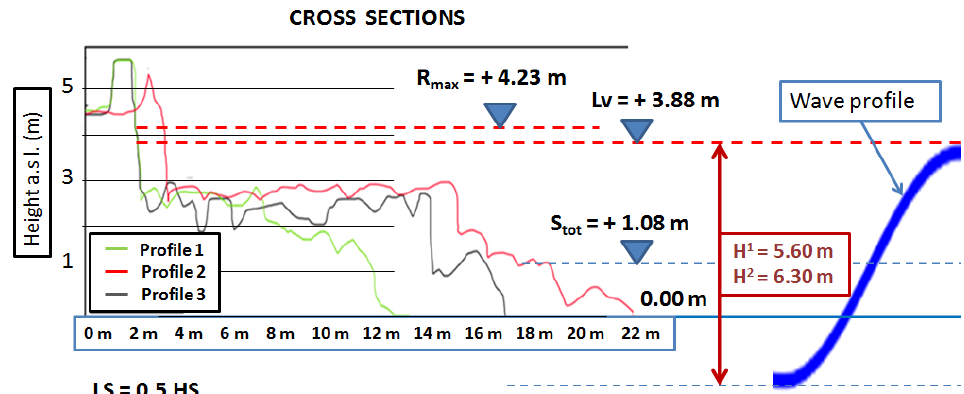
Figure 23. Profile sections in correspondence of the damaged area of Via Partenope: the orthophoto shows the very reduced width of the cliff in Section 1, about half with respect to Section 2. The graphical section (Length Scale LS equal to 0.5 Height Scale HS) gives evidence of the complete overtopping of the cliff during the phase of maximum wave heights. Profile traces are in Figure 22.